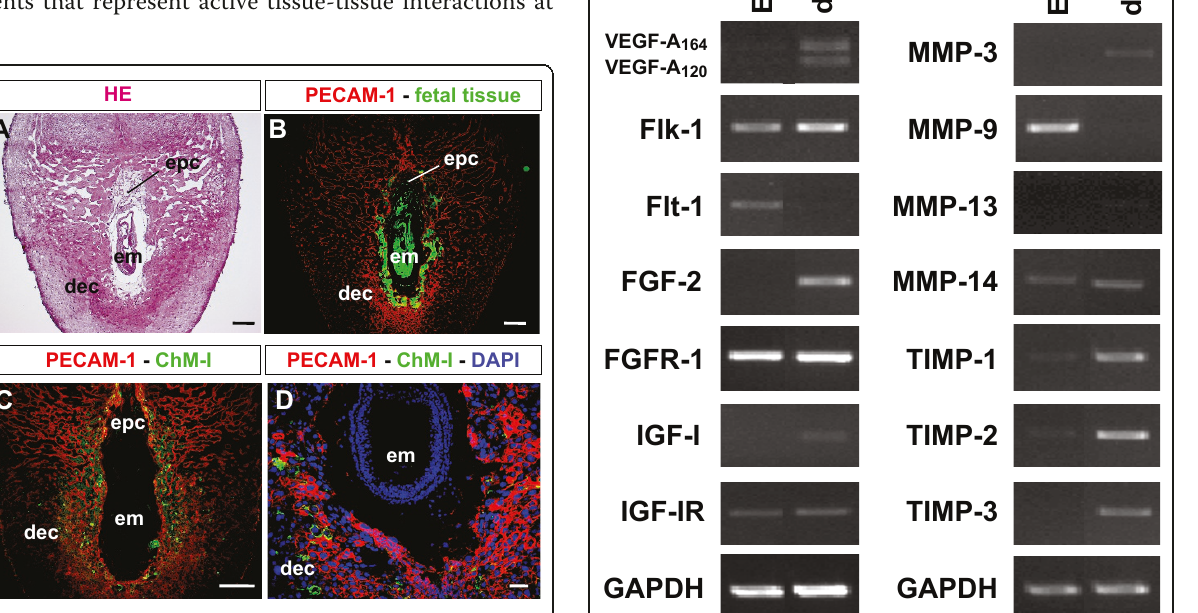
Figure 3 Localization of ChM-I protein in the decidua . (A and B) Visualization of invading fetal tissue through the decidua. Female mice were mated with homozygous EGFP transgenic male mice. At 7.5 days p.c., decidual capsules were dissected from the pregnant mice, fixed, and cryo-sectioned. Semi-serial sections were stained with HE (A) and anti-PECAM-1 antibodies (B, red ), respectively. Fetal tissue ( green ) invading through the maternal decidua was observed under a fluorescence microscope. (C and D) Localization of ChM-I protein and PECAM-1-positive cells. Cryo-sections of 7.5 days p.c. tissues were double-immunostained with anti-ChM-I antibody ( green ) and anti-PECAM-1 antibody ( red ), and counterstained with DAPI (panel D). All images are representative of at least three independent experiments. epc , ectoplacental cone; em , embryo; dec , decidua. Bars in panels A-C, 200 μ m; Bar in panel D, 50 μ m.